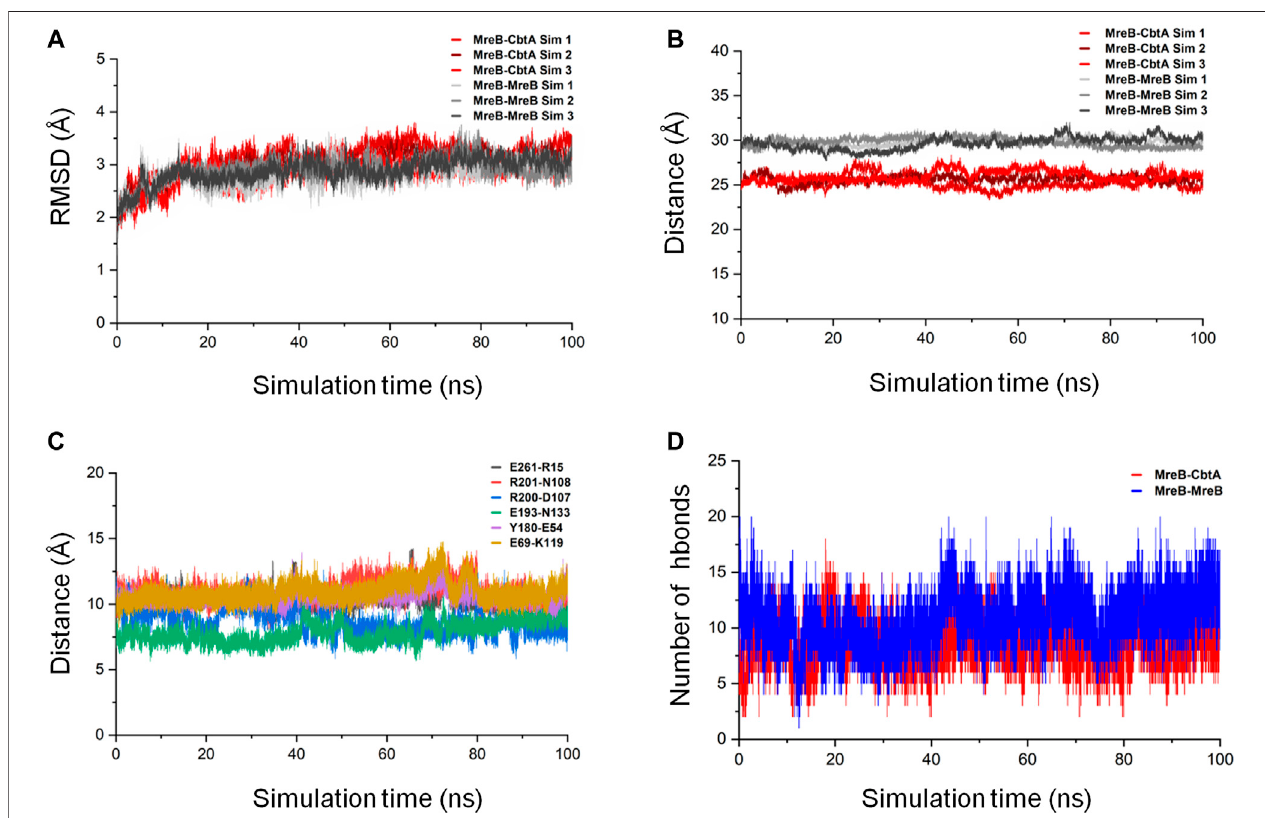
FIGURE 9 | MreB-CbtA and MreB-MreB complex simulation analyses. (A) Backbone RMSDs of the MreB-CbtA and MreB-MreB complexes. The backbone RMSDs for the three MreB-CbtA and three MreB-MreB complex simulations are illustrated by the colors in red shade and gray shade, respectively. (B) Distances between thecenter ofmasses (COMs) ofMreB and CbtA, and theMreB pair. Thedistancesbetween the COMs ofthe MreB and CbtA, and MreB and MreB complexes for the three simulations ineach case areillustratedby the colorsin red shade and gray shade, respectively. (C) Thedistancesbetweenthe COMs ofthe α -Carbon (CA) atoms of the amino acid residue pairs (E261-R15, R201-N108, R200-D107, E193-N133, Y180-E54, and E69-K119) involved in hydrogen bonding between MreB and CbtA. (D) The intermolecular hydrogen bonds (hbonds) between the interacting pairs (MreB-CbtA, and MreB-MreB). The red curve shows the number of hydrogen bonds between MreB and CbtA. The blue curve shows the number of hydrogen bonds between the two MreB